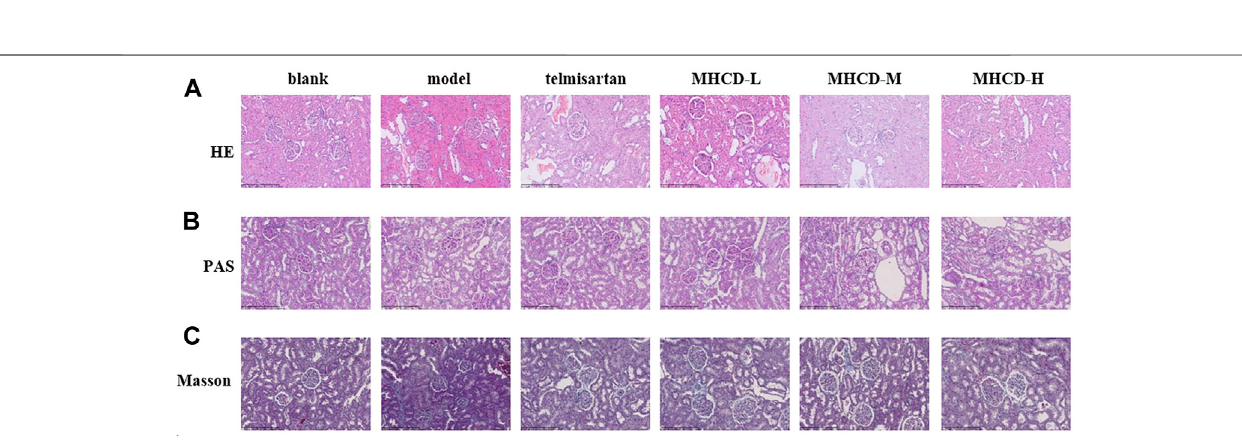
FIGURE 6 | MHCD ameliorates renal histopathology injury (A) Pathologic changes with HE-stained in renal tissue of the six groups (magni fi cation × 200). (B) PathologicchangeswithPAS-stainedinrenaltissueofthesixgroups(magni fi cation × 200). (C) PathologicchangeswithMasson-stainedinrenaltissueofthesixgroups (magni fi cation ×